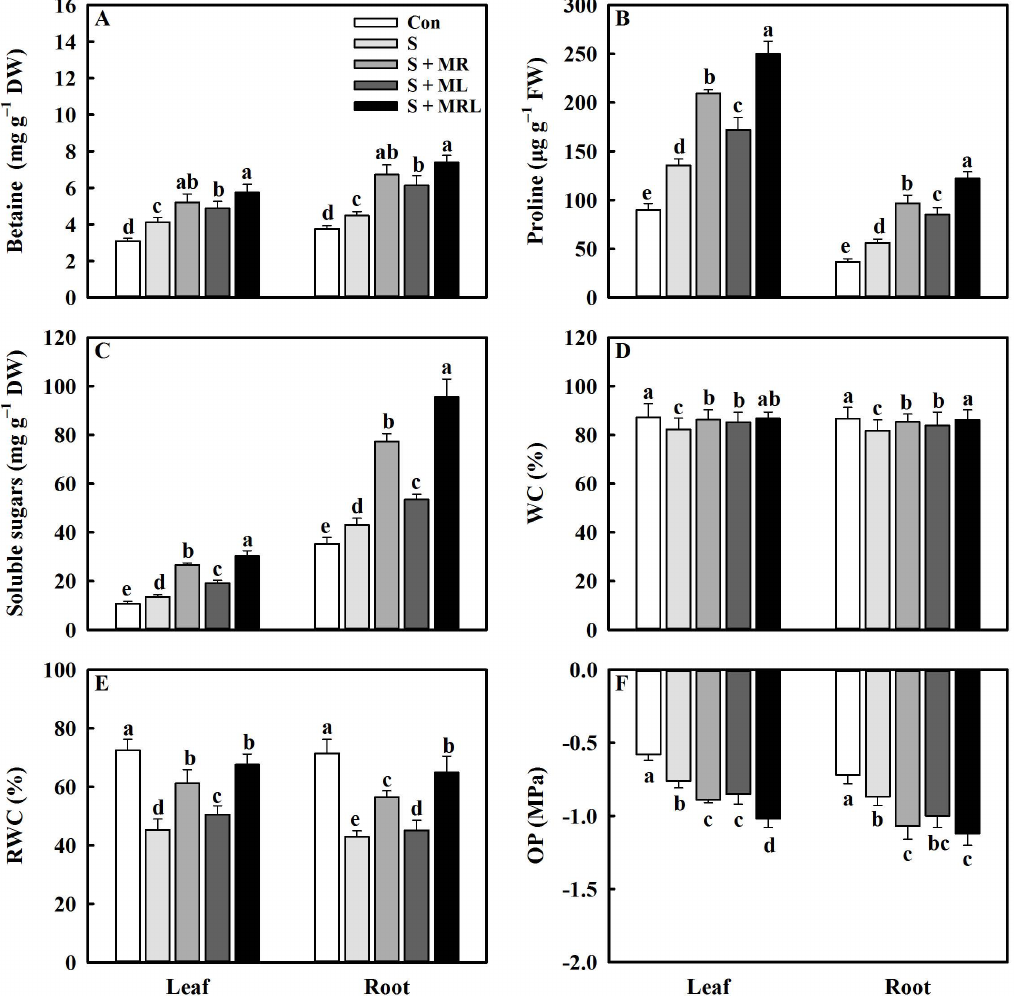
Figure 3. Effect of different methods of melatonin application on the accumulation of osmolytes and water status of sugar beet seedlings under salt stress. ( A ) Betaine content, ( B ) proline content, ( C ) soluble sugar content, ( D ) water content (WC), ( E ) relative water content (RWC), and ( F ) osmotic potential (OP) in leaves and roots. Con, control treatment; S, salt stress treatment; S + MR, salt stress treatment + root application of melatonin; S + ML, salt stress treatment + foliar application of melatonin; S + MRL, salt stress treatment + combined root and foliar applications of melatonin. Data show the means ± standard errors ( n = 4). Different letters indicate significant differences between treatments according to Duncan’s multiple range test ( p <